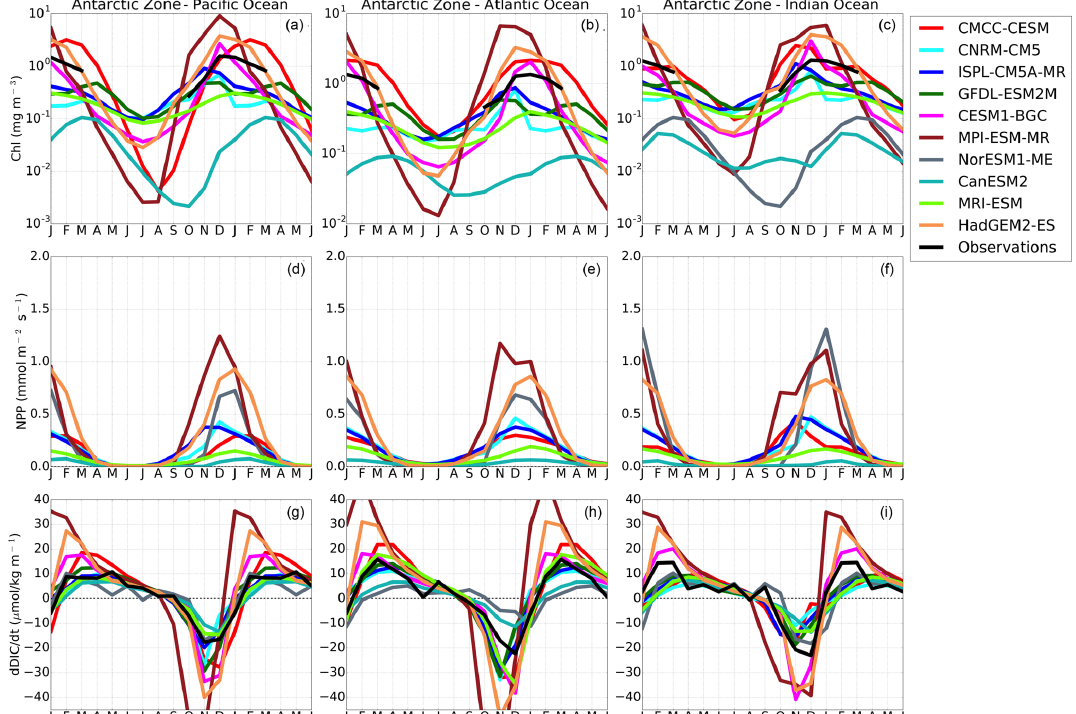
Figure 9. Same as Fig. 8 for the Antarctic